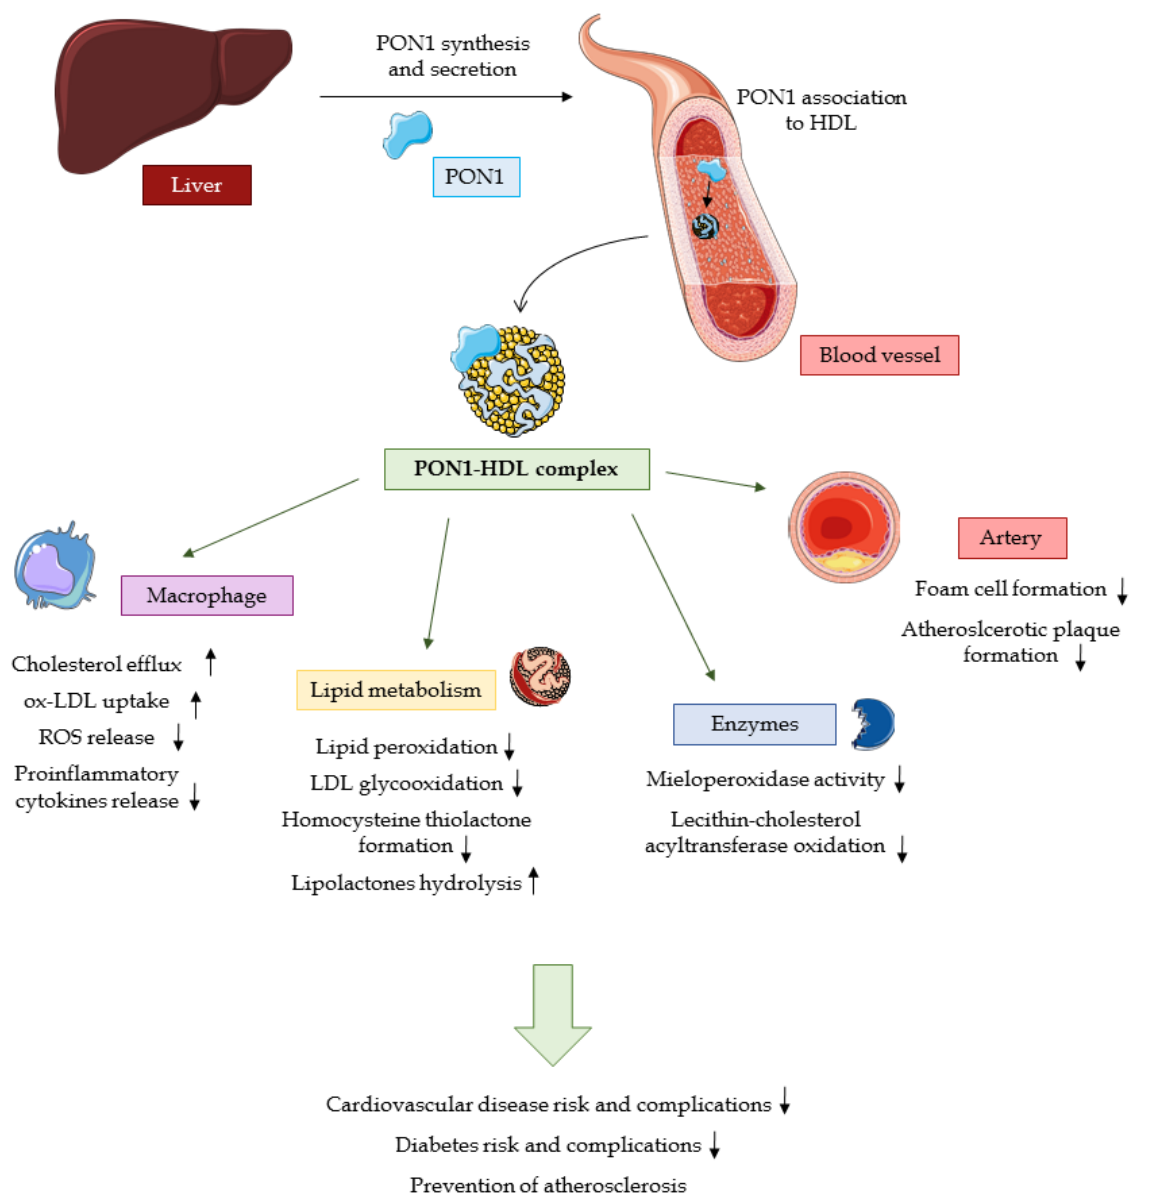
Figure 2. A schematic representation of PON1-HDL complex, formed after PON1 had been synthe- sized in the liver and secreted to the bloodstream, functions in overall cardiovascular risk reduction and disease prevention. Figure created with the use of Servier Medical Art by Servier.